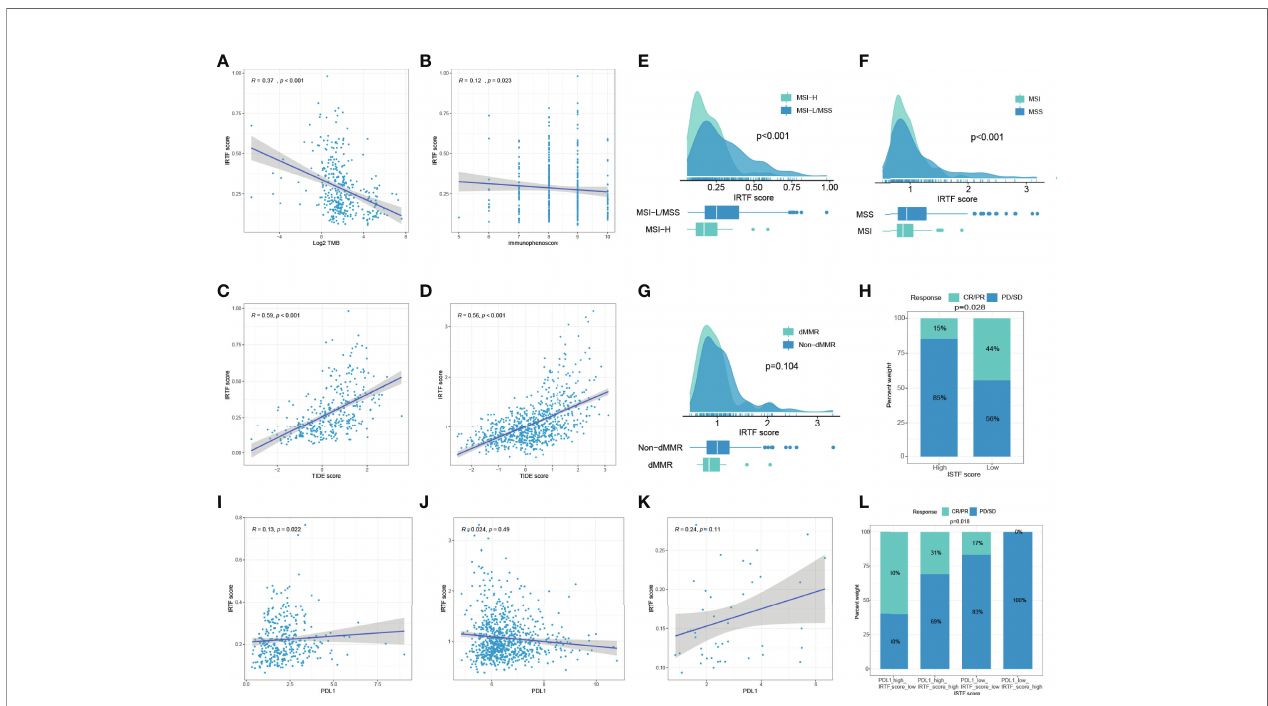
FIGURE 4 | IRTF score system in the role of immunotherapy of GC. (A – D) Correlation analysis of IRTF scores with immunotherapy-related markers, including TMB, immunophenoscore, and TIDE scores for the TCGA-STAD cohort (A – C) and the combined cohort (D) . Correlation analysis of IRTF scores with MSI/dMMR status for the TCGA-STAD cohort (E) , the ACRG cohort (F) , and the PUCH cohort (G) . (H) The proportion of GC patients showing response to anti-PD1 antibody in the low or high IRTF score groups. (I – K) Correlation analysis of IRTF scores with PDL1 for the TCGA-STAD cohort (I) , the combined cohort (J) , and the ERP107734 cohort (K) . (L) The proportion of GC patients showing response to anti-PD1 antibody in four different groups based on the PDL1 mRNA and the IRTF scores.